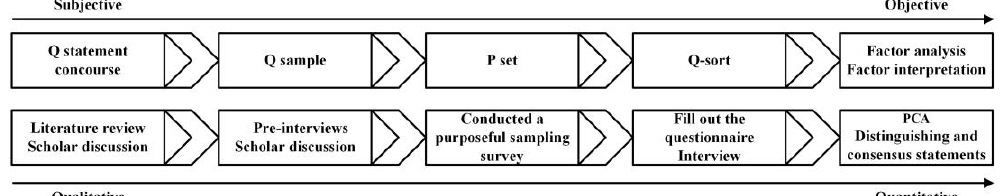
Figure 3. Framework of conducting Q methodology research.